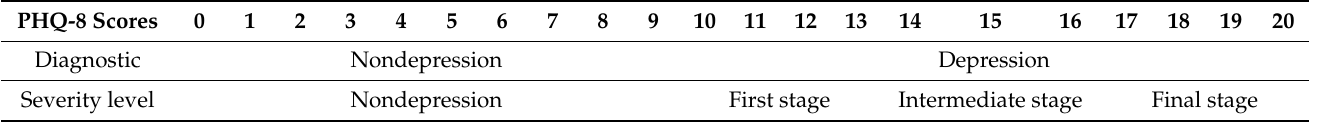
Table 2. Severity levels according to the PHQ-8 score.